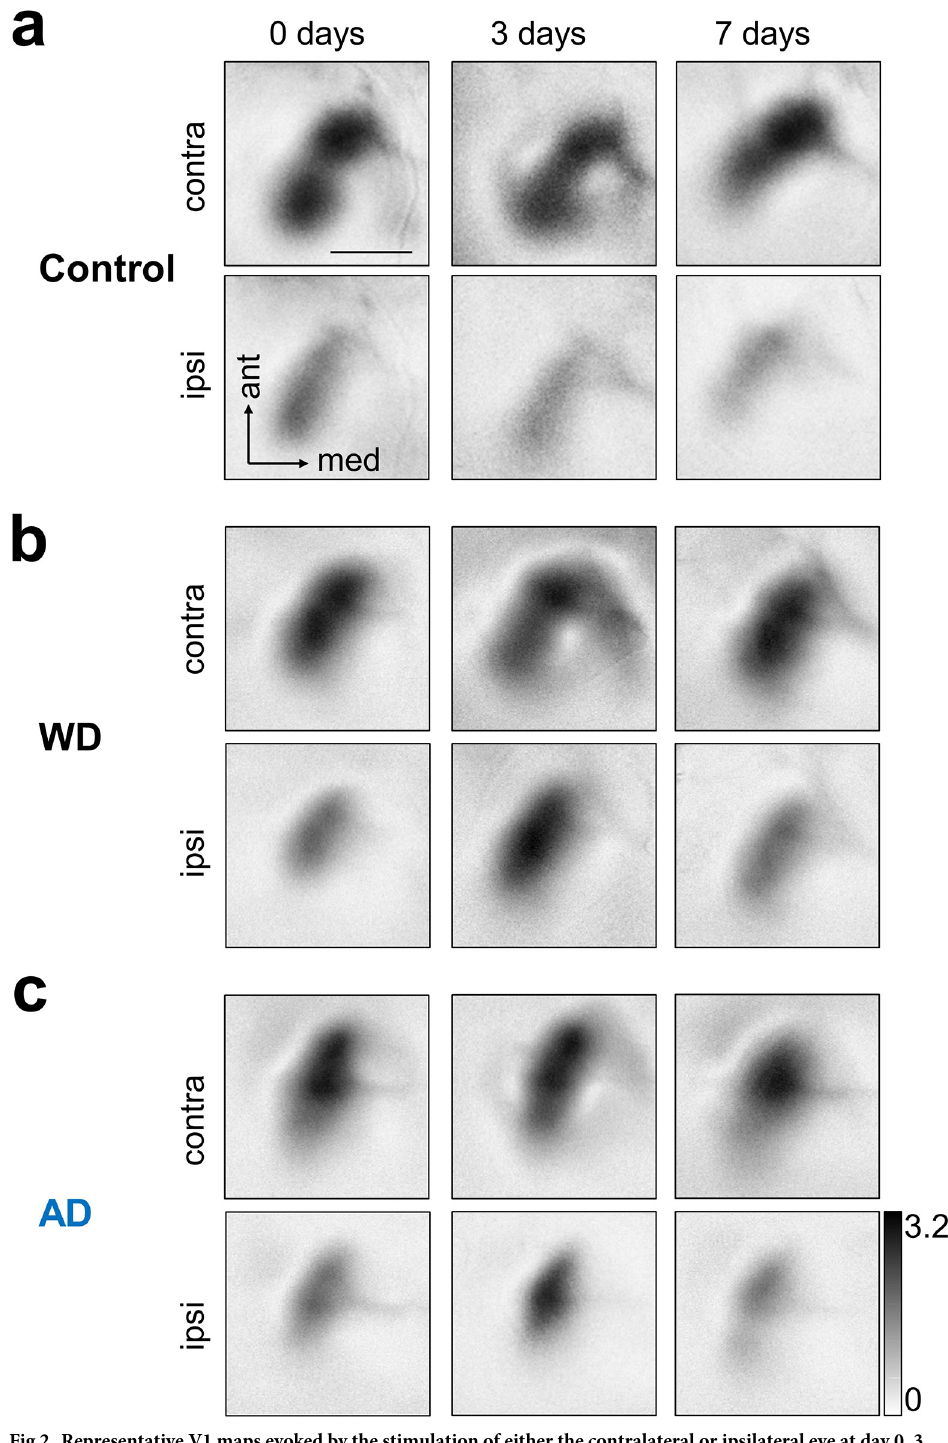
Fig 2. Representative V1 maps evoked by the stimulation of either the contralateral or ipsilateral eye at day 0, 3 and after 7 days. ( a ) Upper row: In normal control mice contralateral eye stimulation always evoked similarly strong V1 responses. Lower row: V1 responses evoked by ipsilateral eye stimulation were equally strong over the time tested but these responses were always weaker that V1 maps obtained after visual stimulation of the contralateral eye. ( b ) Upper row: Like in control mice, WD did not lead to alterations of V1 responses elicited by contralateral eye input. Lower row: However, V1 responses elicited by ipsilateral eye stimulation markedly increased 3 days after WD